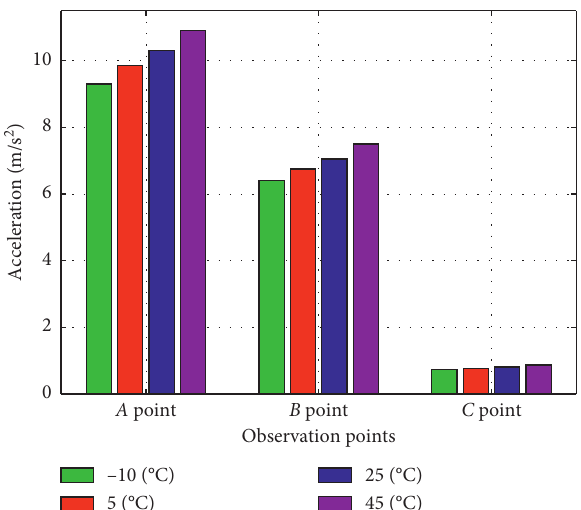
Figure 10: The temperature effect on the vertical accelerations at all observation points with the speed of 350km · h − 1 .